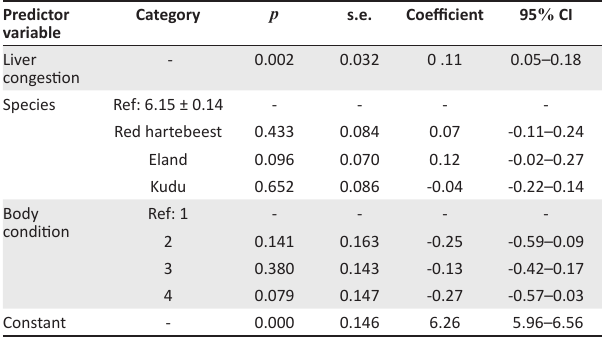
TABLE 4: Results from a multivariable linear regression model of the effect of congestion on pH of game liver 4 h post-slaughter. Predictor variable